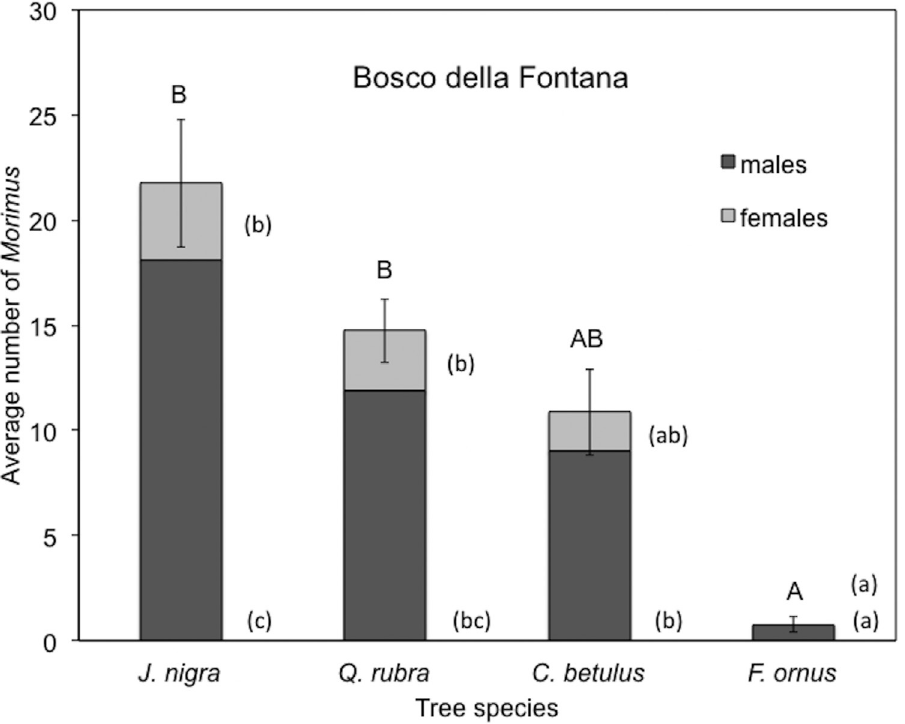
Figure 2. Bosco della Fontana. Average number (±SE) of adults of M. asper observed per sampling on the seven wood piles built from wood of different tree species. Different capital and small letters above columns (total adults) and on the right (males and females) indicate significant differences among wood types at the 0.01 and 0.05 levels, respectively (Dunn’s Multiple Comparisons